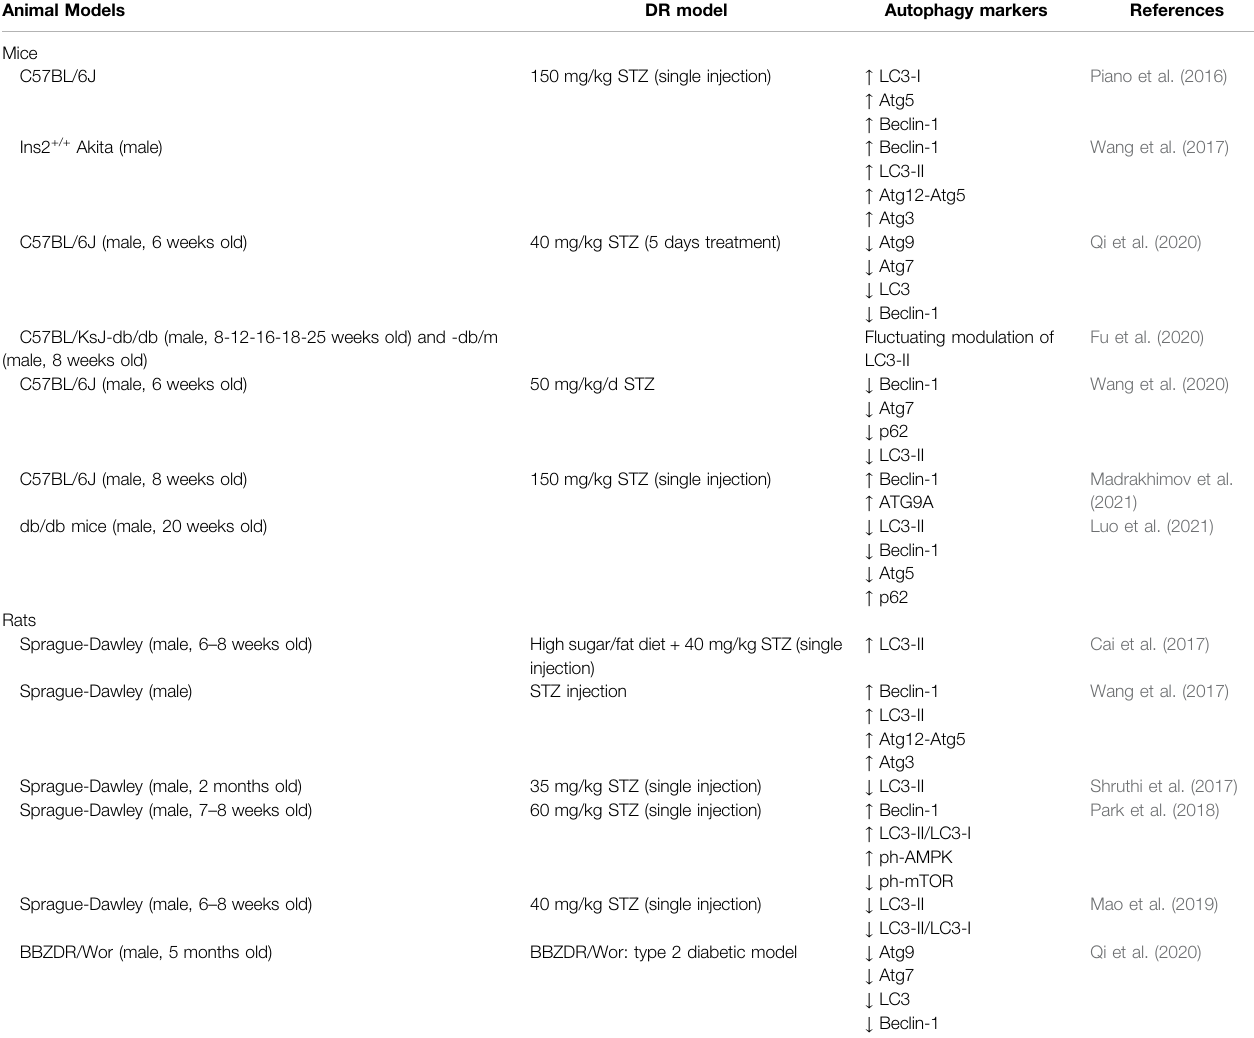
TABLE 1 | Autophagy modulation in animal models of diabetic